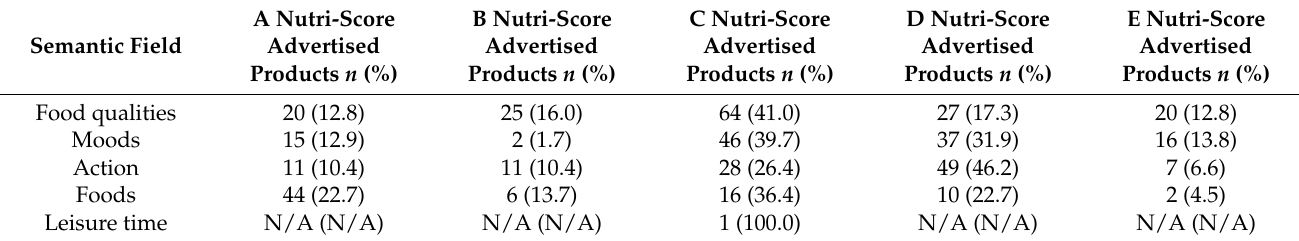
Table 4. Correlation between the Nutri-score value and the semantic field that described the product. A Semantic Field